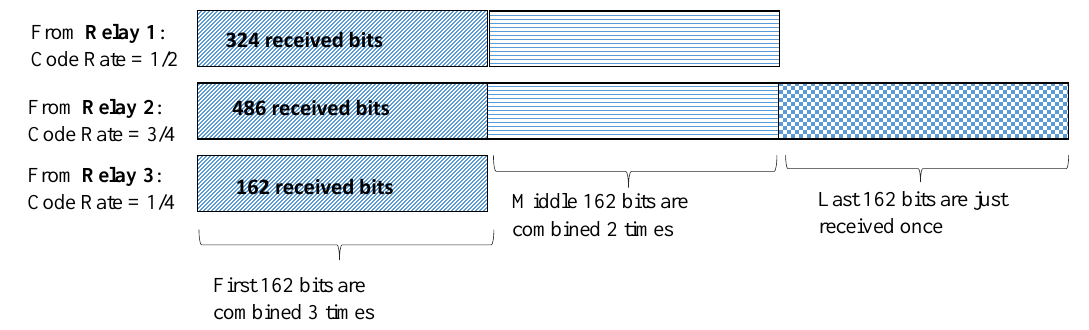
Figure 9. OPA (optimized power allocation) Example: Number of effective information bits, received and combined (from three relays), codeword length = 648, m 1 = 3, m rd = { 3,3,1 } , source code rate 3/4, and